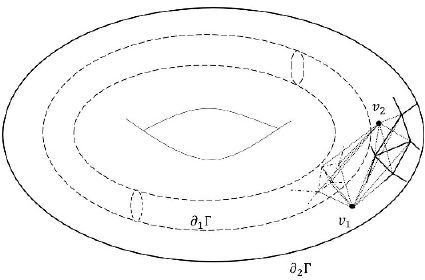
Figure 4. A 3-cylinder, i.e., a solid torus with a solid torus removed from interior. This is an example of a 3-manifold with two boundaries, the inner boundary (dashed line) ∂ 1 Γ and the outter boundary (solid line) ∂ 2 Γ. A portion of the triangulation Γ of this 3-cylinder is shown, where v 1 and v 2 are two vertices in the bulk.